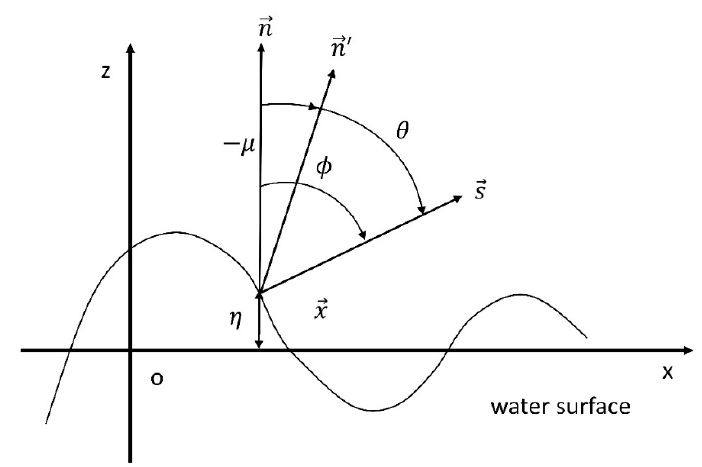
Figure 1. Cartesian coordinate system. (Modified from Yoshimori et al. [21]).